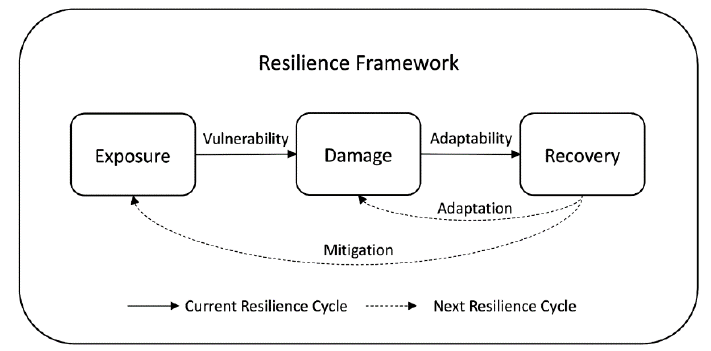
Figure 1. The Resilience Inference Measurement (RIM) framework [7].